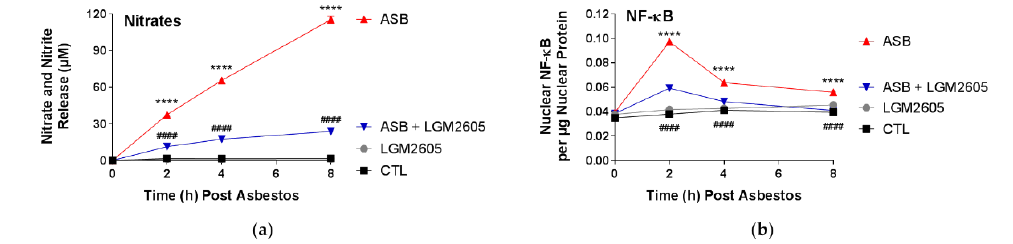
Figure 4. LGM2605 Prevents Asbestos-Induced Nitrosative Cell Damage and NF- κB Activation. Hu- man pleural mesothelial cells were plated in a 6-well plate (1 × 10 6 cells/well) and exposed to 50